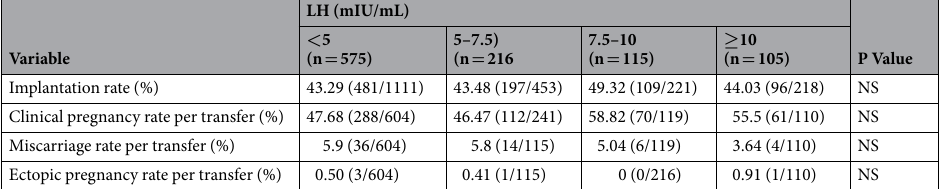
Table 3. FET cycle outcomes. NS: not